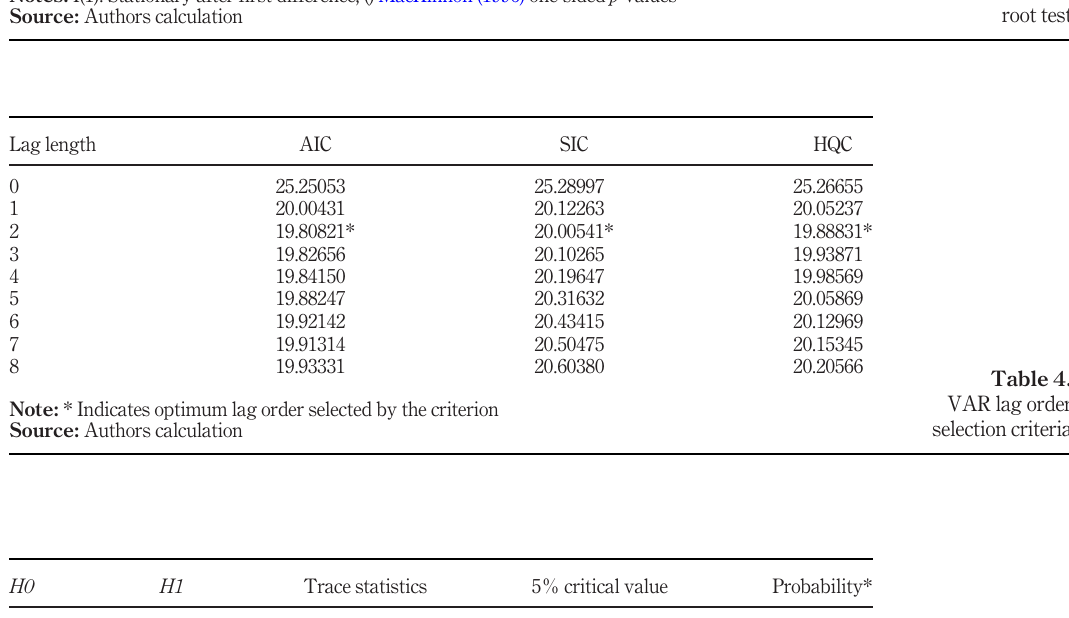
Table 5. Results of